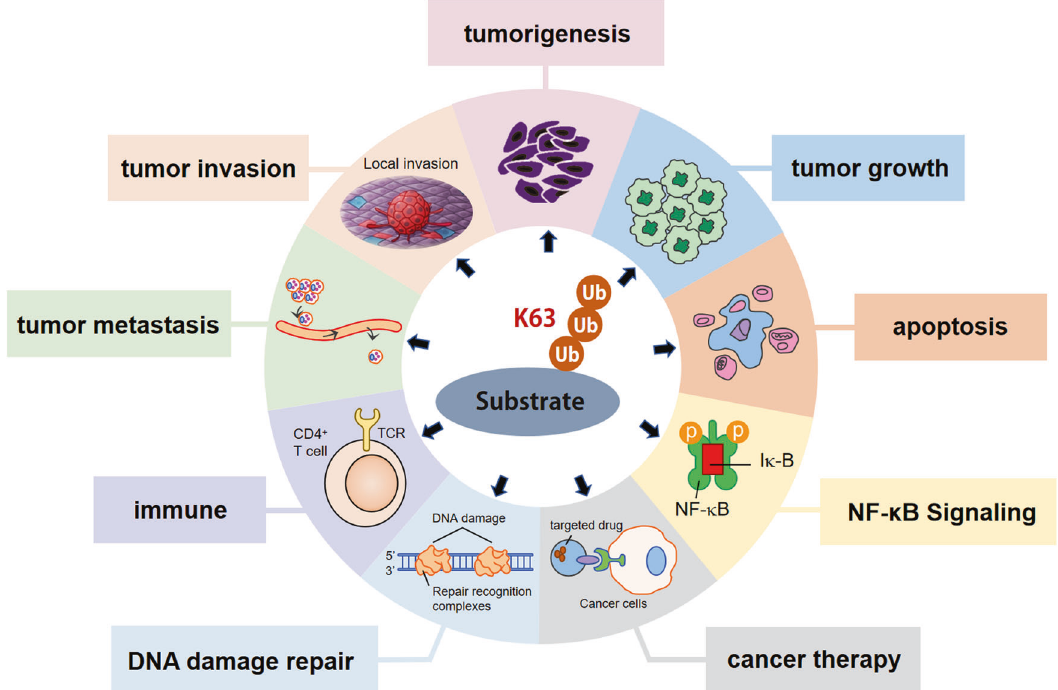
Fig. 1 K63-linked ubiquitination regulates multiple aspects of cancer. Various aspects of tumor have been reported to beclosely regulated by K63-linked ubiquitination including tumorigenesis, tumor growth, tumor invasion, tumormetastasis, immune, apoptosis, NF- κ B signaling, DNA damage repair and cancer